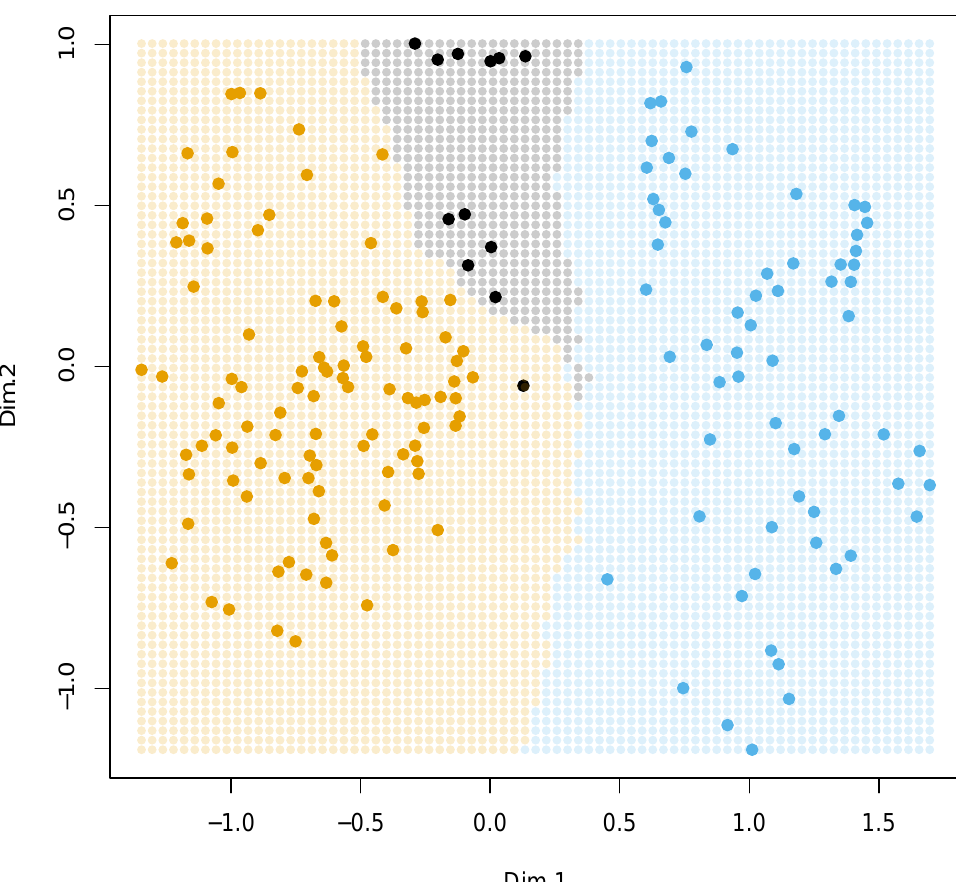
Figure 7. k -nearest neighbors ( k -NN) plane predicts Plantago subgenera from the combined molecular and morphological data. The combined data was projected into a 2-dimensional plane. Solid dots correspond to Plantago subgg. Plantago (brown), Coronopus (black), Psyllium and Albicans (blue). For each location shown as a semi-transparent dot, subgeneric placement learned with the k-NN algorithm, and the dot was colored following this prediction. Now, if any new species appear which corresponds with any of these semi-transparent dots, its subgeneric placement is already